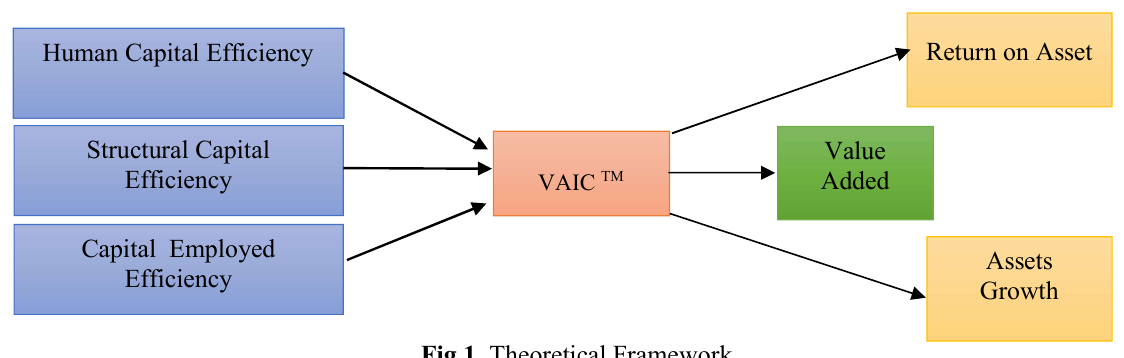
Fig 1 . Theoretical